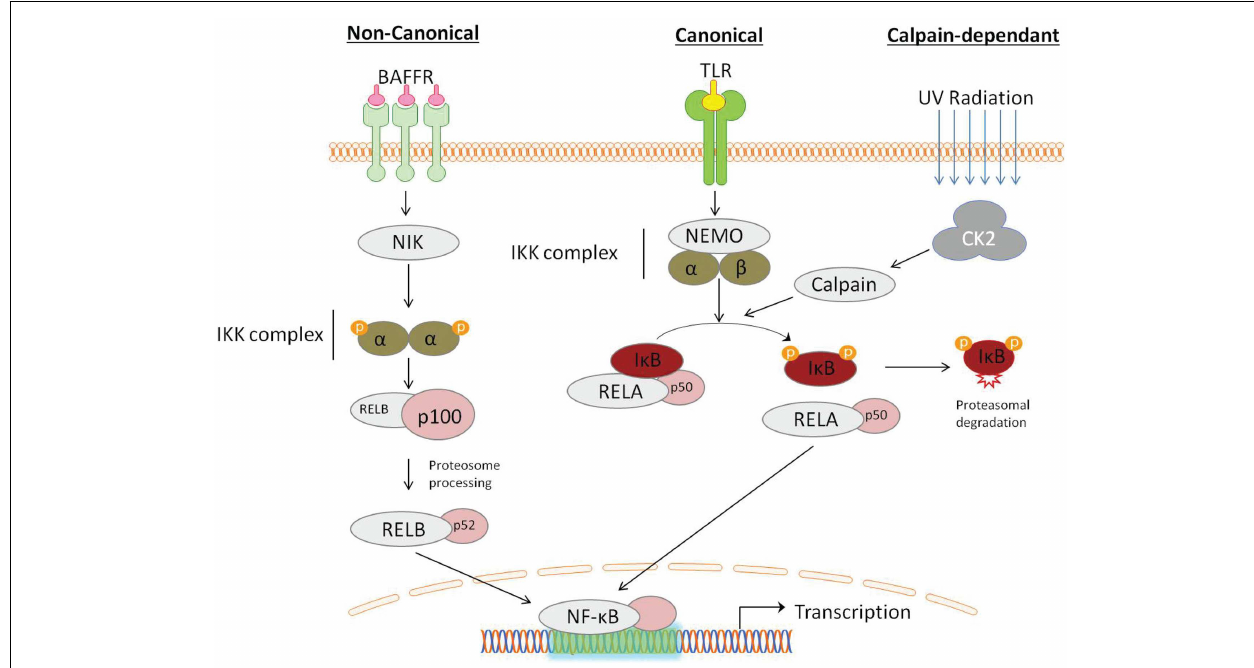
receptor (TNFs) members, is dependent on the NF- κ B-inducing kinase (NIK), which activates proteolytic processing of p100 by IKK α . NF- κ B activation can also occur through a IKK-independent mechanism, induced by DNA damage detection, involving the serine threonine kinase casein kinase 2 (CK2), which activates the I κ B targeting cysteine protease